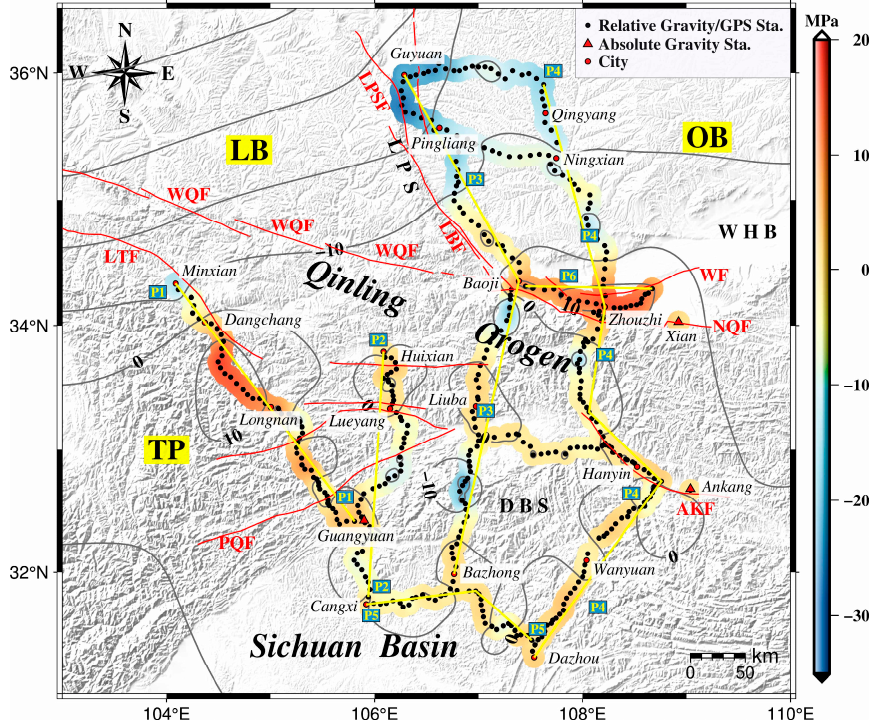
Figure 8. Distribution of isostatic additional force map in the Qinling area. Abbreviations are the same as those used in Figure 1.